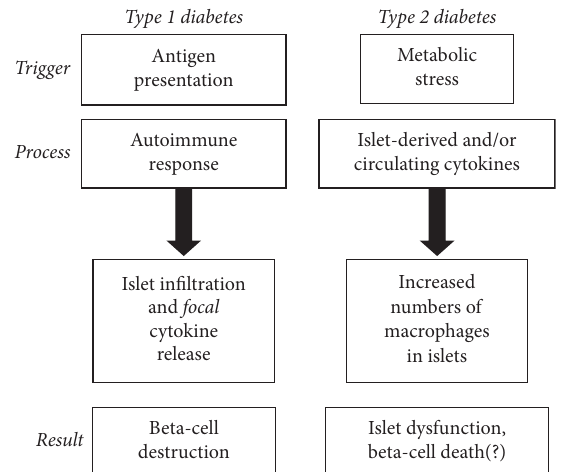
Figure 1: A flowchart of very basic differences in the patho- physiology of T1D and T2D. Each disease is described by the immune-mediatedtriggers,processes,andresultswithrespecttothe pancreatic